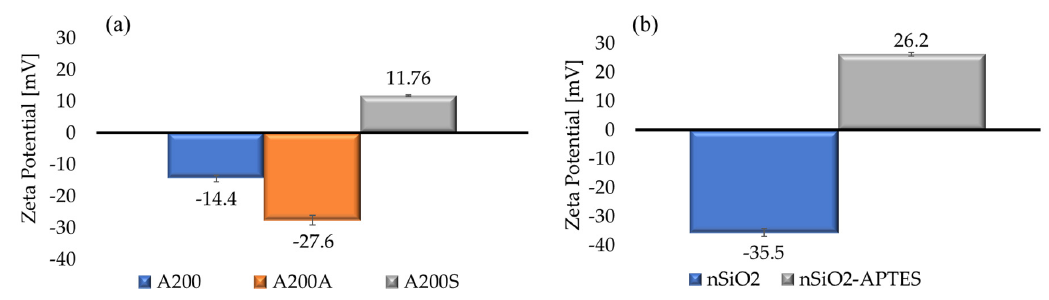
Figure 10. ζ -potential values of ( a ) A200, A200A and A200S, and ( b ) nSiO 2 and nSiO 2 -APTES NPs.